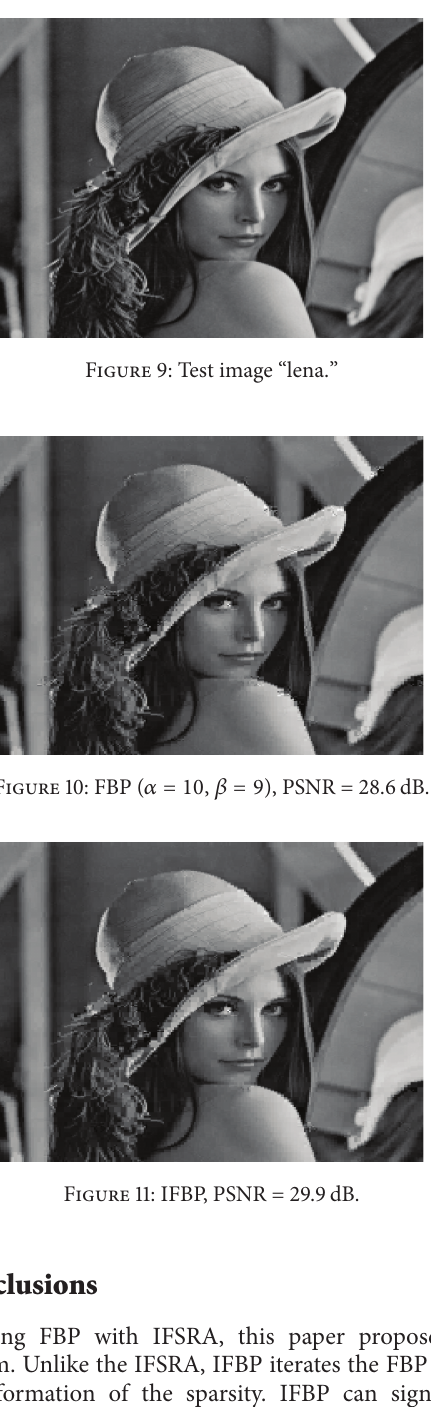
Figure 9 is the test image “lena.” The results of FBP and IFBP are shown in Figures 10 and 11. In this example, the Peak Signal-to-Noise Ratio (PSNR) value of FBP is 28.6 dB, while IFBP promotes the PSNR up to 29.9 dB. This example shows that IFBP has the ability to generate more accurate recovery than FBP for a signal with realistic nonzero coefficient distribution.